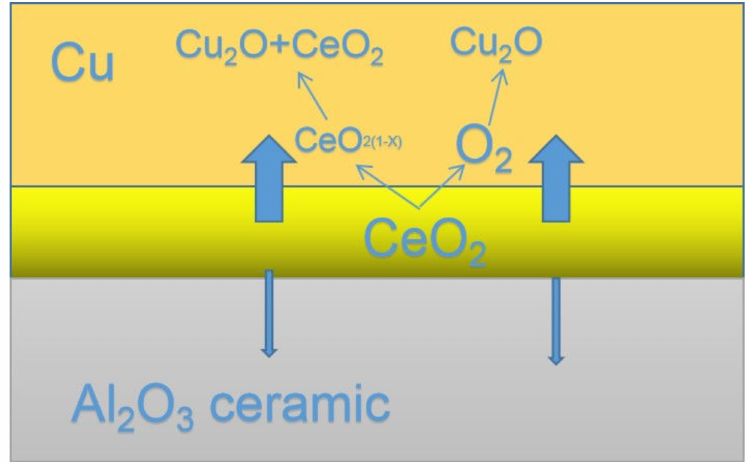
Figure 9. Mechanism of Cu-Cu 2 O-CeO 2 eutectic liquid formation at bonded temperature 1300 ◦ C.